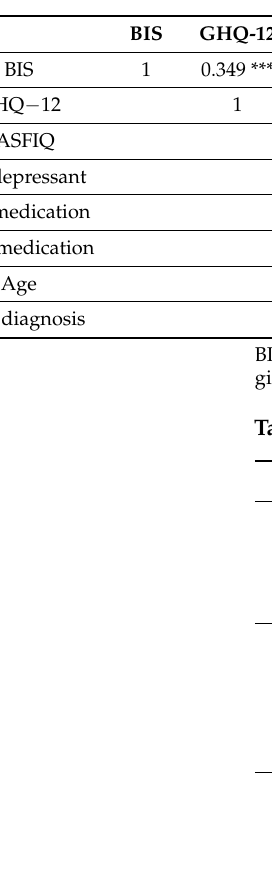
Table 2. Associations of BIS with other variables.